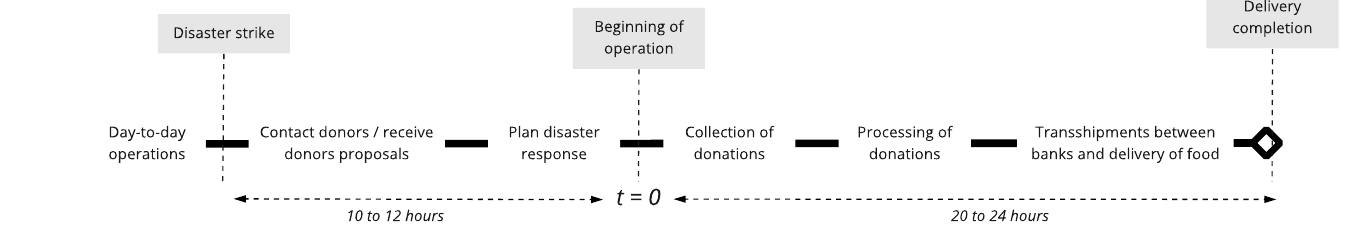
Figure 1. BAMX ’ s response to a sudden natural disaster. Figure 1. BAMX’s response to a sudden natural